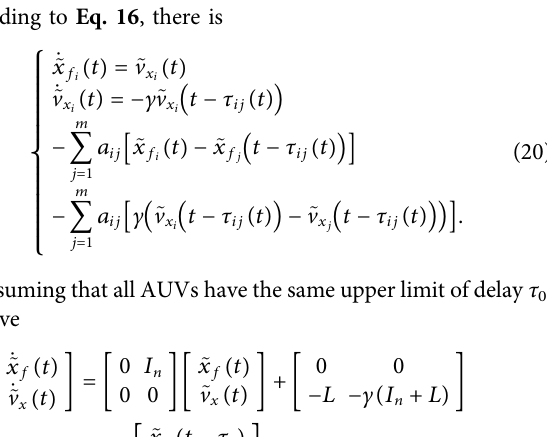
FIGURE 3 | Communication topology